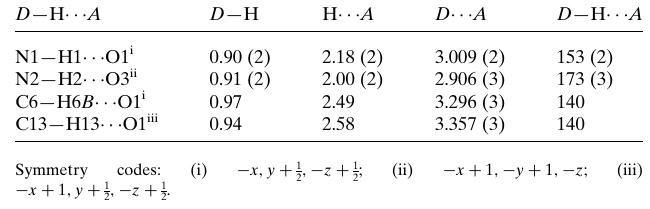
Table 2 Experimental details.